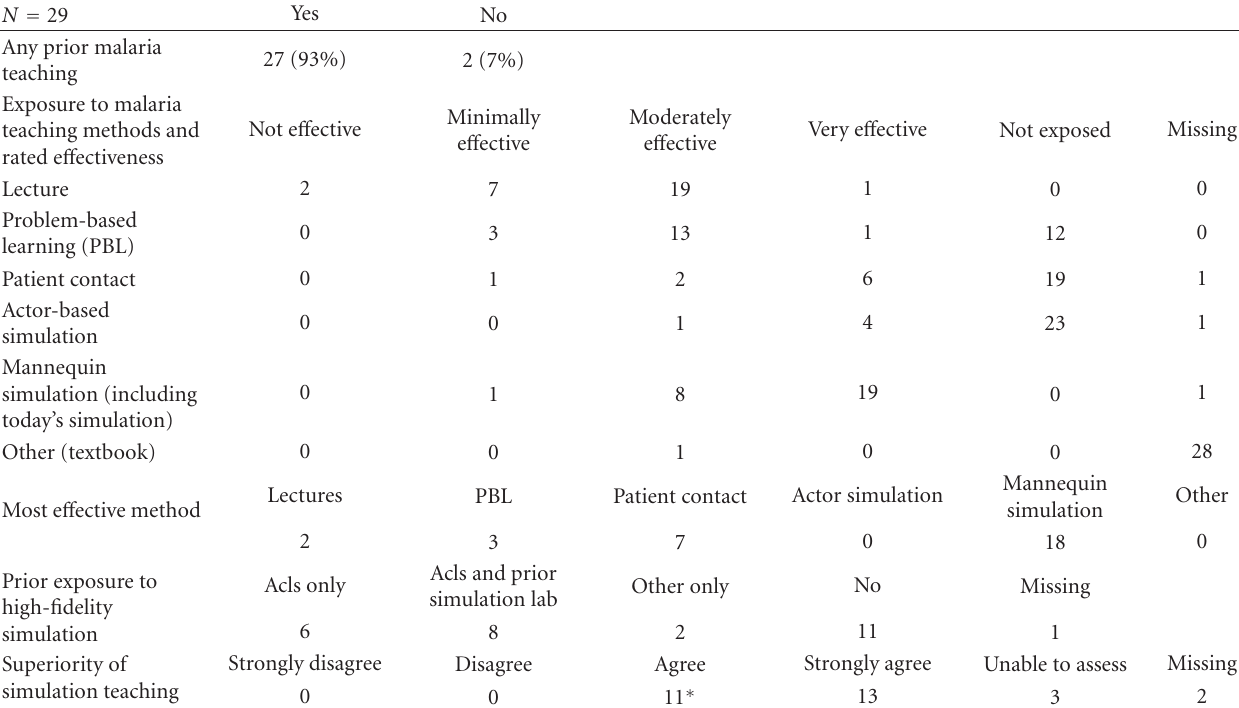
Table 2: Prior malaria teaching, prior simulation experience, and teaching e ff ectiveness.